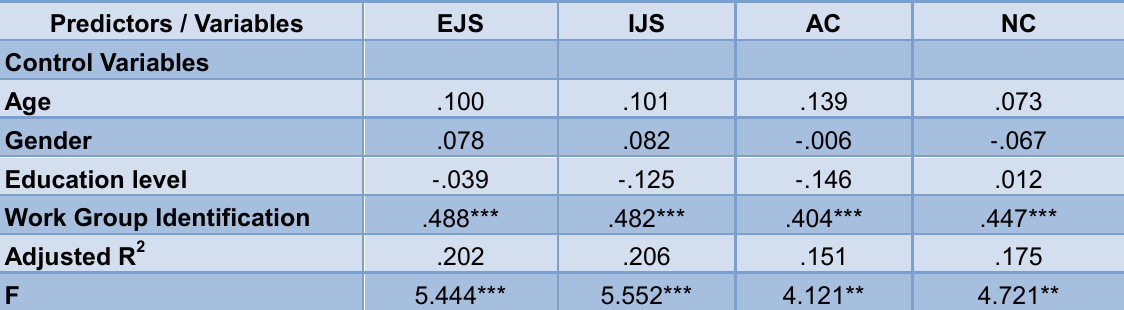
identification: an examination of the quantity surveyors in Hong Kong’ , Australasian Journal of Construction Economics and Building, 13 (3) 80-95